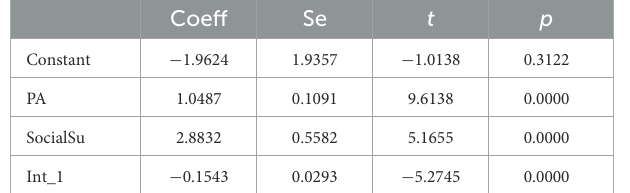
TABLE 7 Genuine acting and personal accomplishment, with salary as the